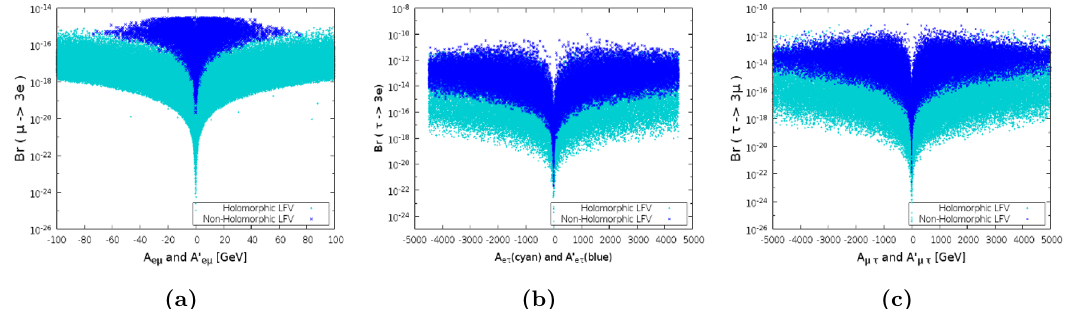
Figure 9. E(cid:11)ect of imposing the LHC constraints on Y ij on the analysis of (cid:12)gure 5: scatter plots of Br ( (cid:22) 3 e ) with A e(cid:22) and A 0 ! A 0 are shown in (cid:12)gure 9(b). Figure 9(c) is for Br ( (cid:28) e(cid:28)